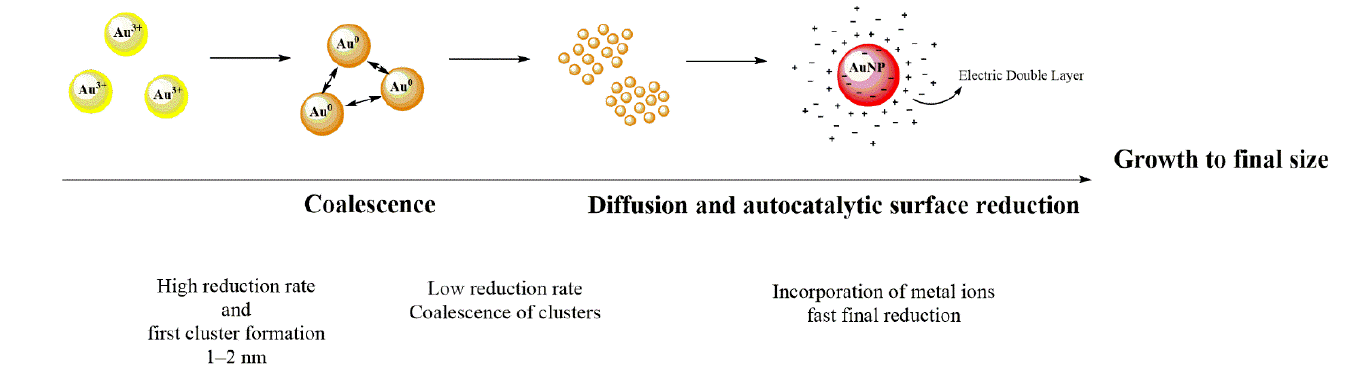
Figure 2. Colloidal gold nanoparticle (AuNP) formation process.